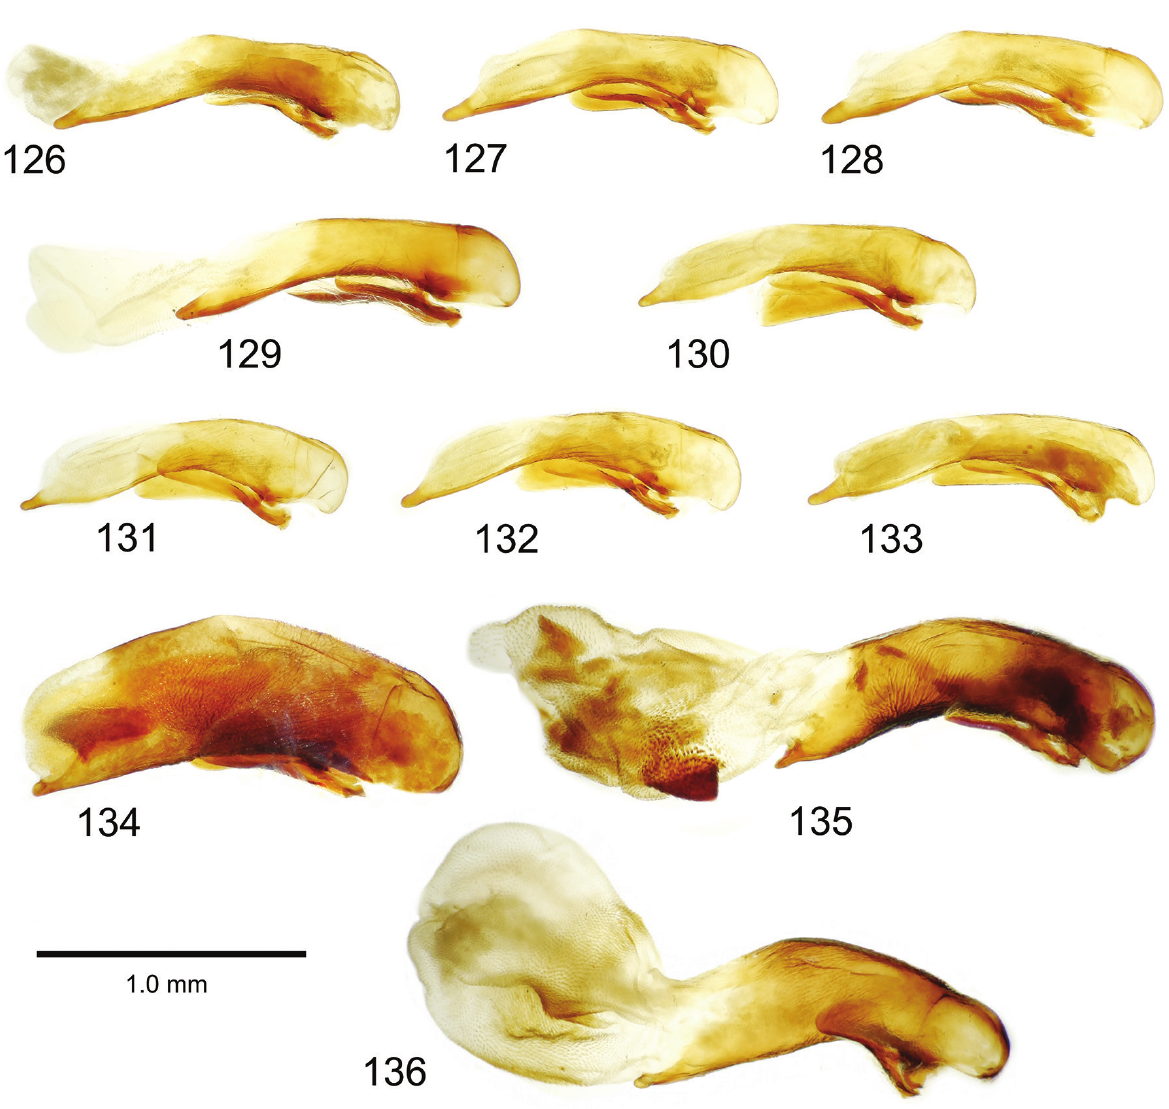
Figures 126–136. Male aedeagal median lobe and associated parameres of Cyphocoleus spp., dextral view: 126–133 , C. latipennis ; 126 , internal sac everted, Mandjélia; 127–128 , Mandjélia; 129 , Mt. Panié; 130 , Pic d’Amoa; 131–132 , Aoupinié; 133 ,